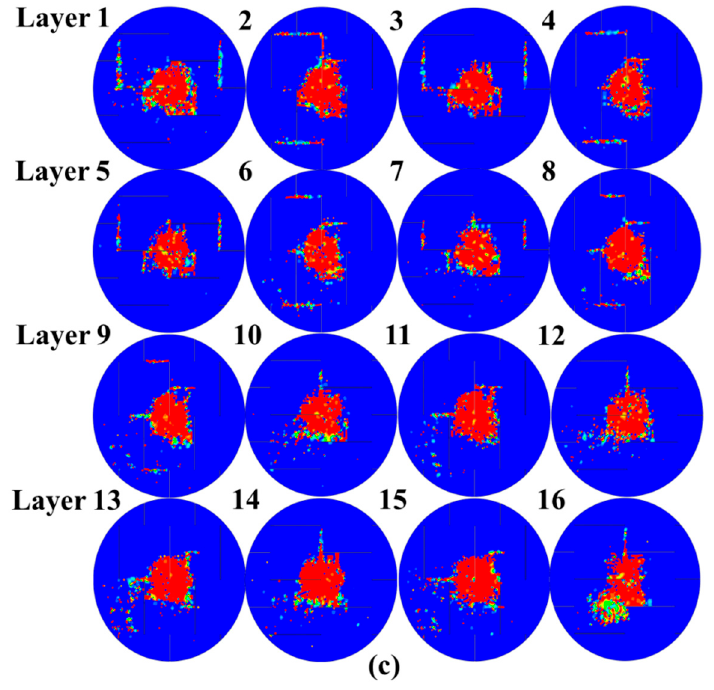
Figure 11. Matrix tensile damage of UACS laminates under impacts at ( a ) 4 J, ( b ) 7 J and ( c ) 11 J.